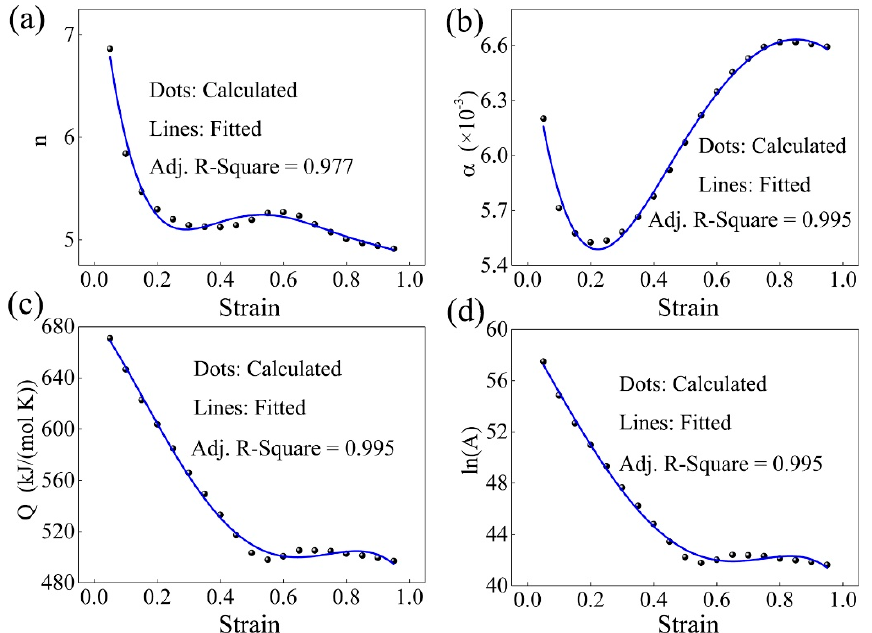
Figure 4. The Arrhenius model parameter values of GH4698 alloy at various strains. ( a ) n , ( b ) β , ( c ) Q , and ( d ) ln A.